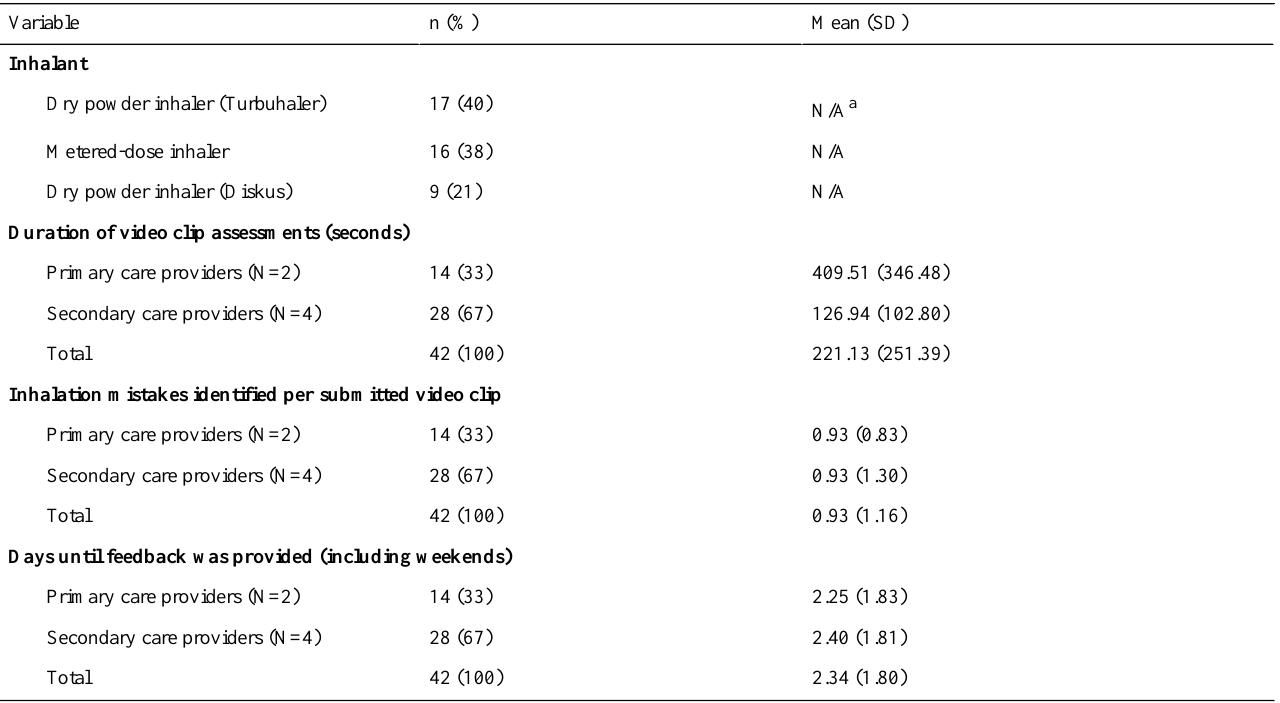
Table 2. Descriptive statistics of inhalation video clip assessments